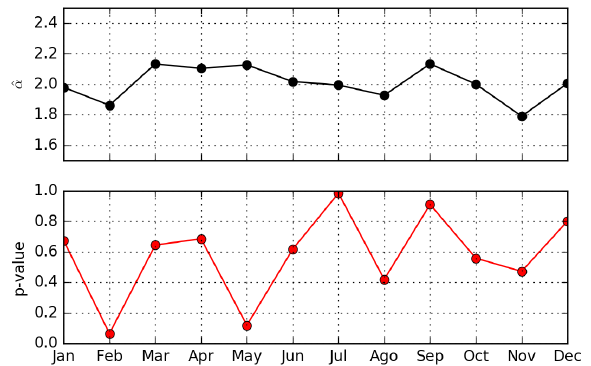
Figure 2. Estimation of the Pareto-shaped parameter ˆ α and the related p -value of the 1000 most popular Wikipedia pages in